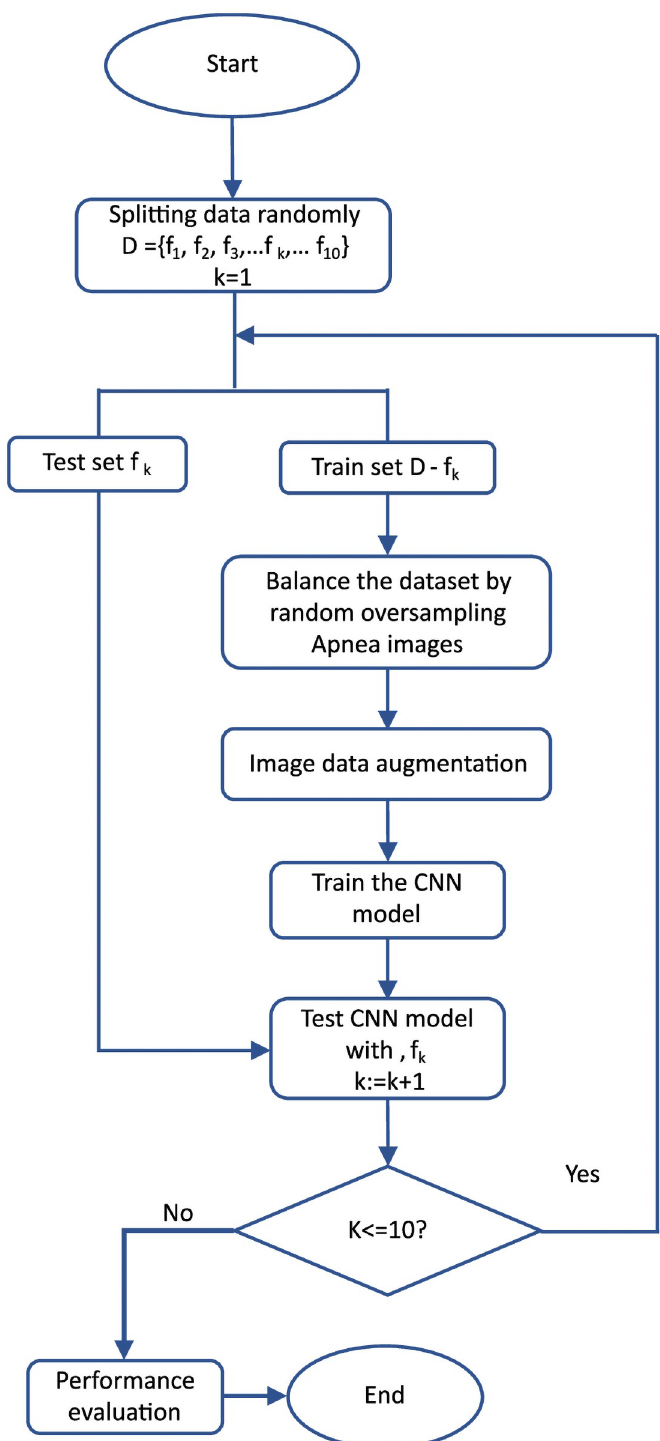
Fig 6. Schematic diagram of the training procedure for the proposed 2D-CNN model with 10-fold cross validation.